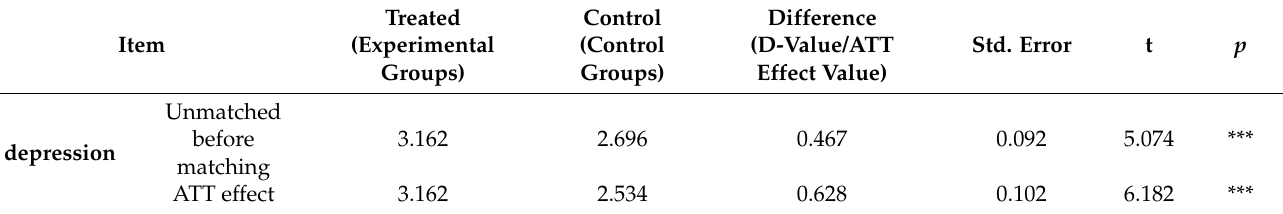
Table 5. ATT effect